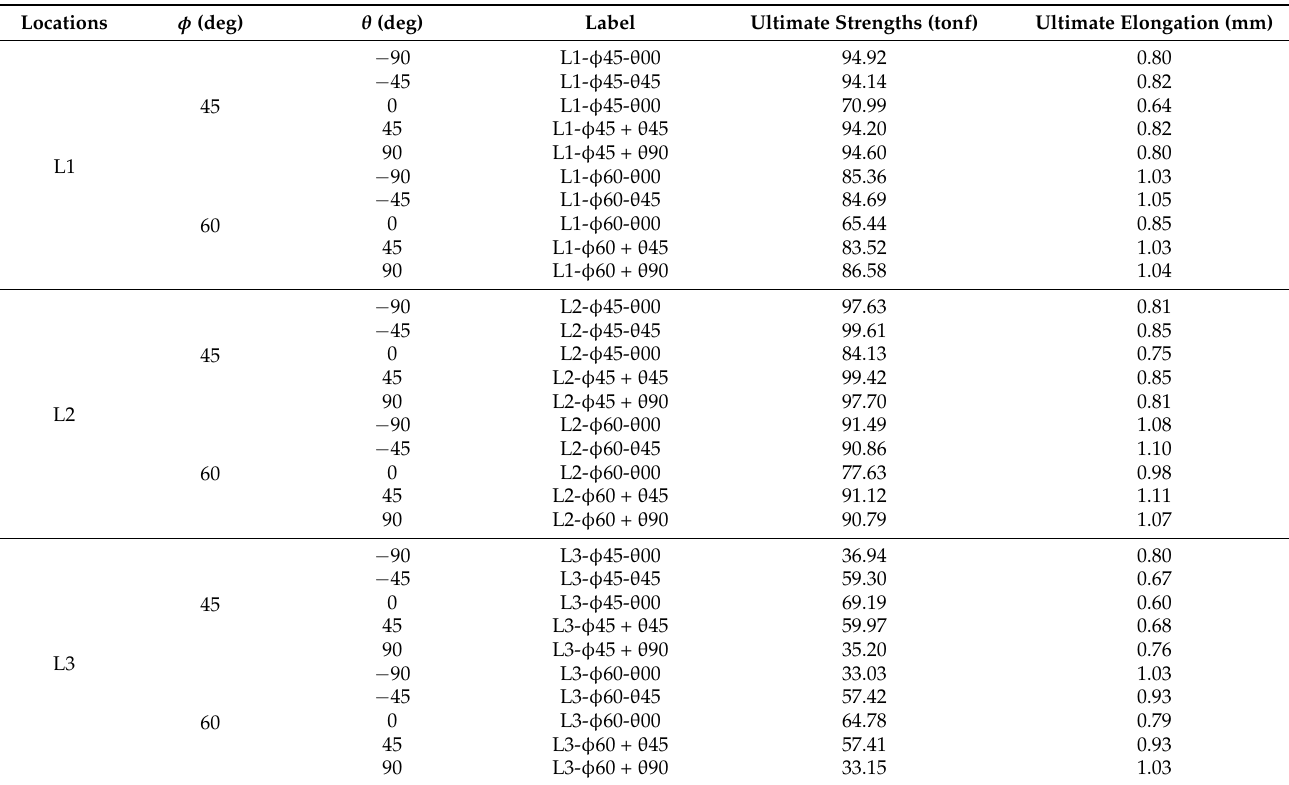
Figure 10. Convergence study for the mesh size sensitivity at different D-ring locations. The tangent intersection method was used to identify the ultimate strength of the deck structure. The numerical results are listed in Table 8. The label has Lx- φ yy- θ zz where x is the type number, yy is the out-of-plane angle, and zz is the in-plane angle. The minimum ultimate strength of 29.82 ton f of the deck structure was obtained at L6 with φ of 60 ◦ and θ of 0 ◦ , which was considerably larger than the MBL of the lashing device. Considering the thickness of the deck structure, the ultimate strength of the deck structure was less than the CS of the D-rings for L5 and L6. The lowest ultimate strength was obtained for L6- φ 60- θ 00, where only a type 1 D-ring can be applied (see Table 9). Table 8. Nonlinear FEA results for the deck